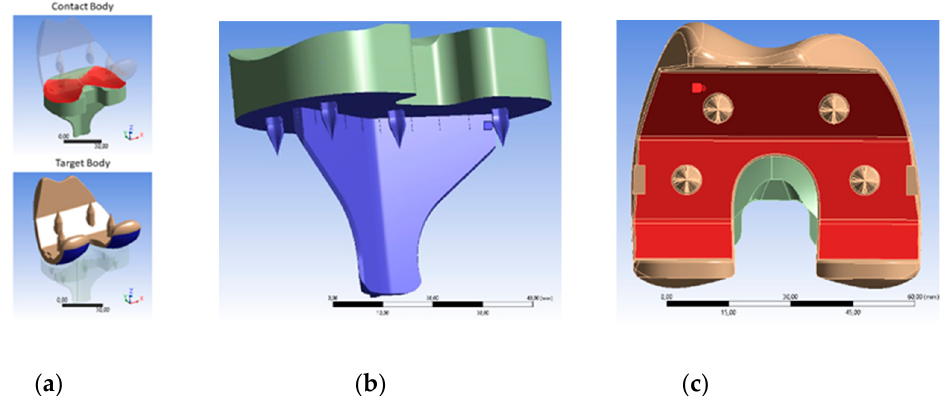
Figure 5 . Main characteristics considered in the pre-processor: ( a ) contact properties; ( b ) definition of the fixation; ( c ) definition of the applied force.